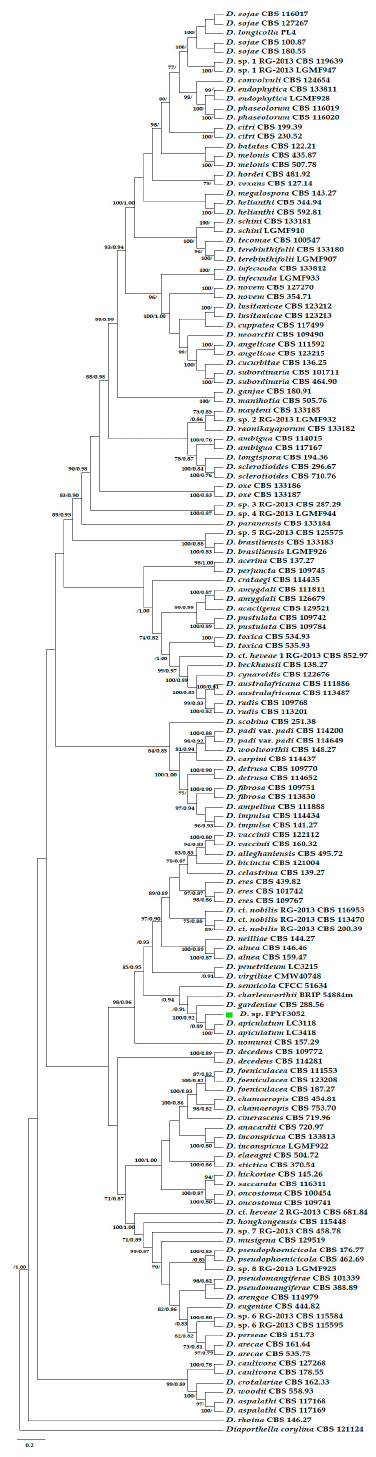
Figure 2. A multigene phylogenetic tree of ITS, CAL, HIS, TEF1 , and TUB sequence alignment based on Bayes and MP analysis. The MP bootstrap values ≥ 70 or Bayesian probabilities PP ≥ 0.75 are marked above the branches (MP bootstrap value / Bayes poster probability value) The tree was rooted with Diaporthella corylina . The endophytic isolate was named with strain ID FPYF 3052 marked green box.